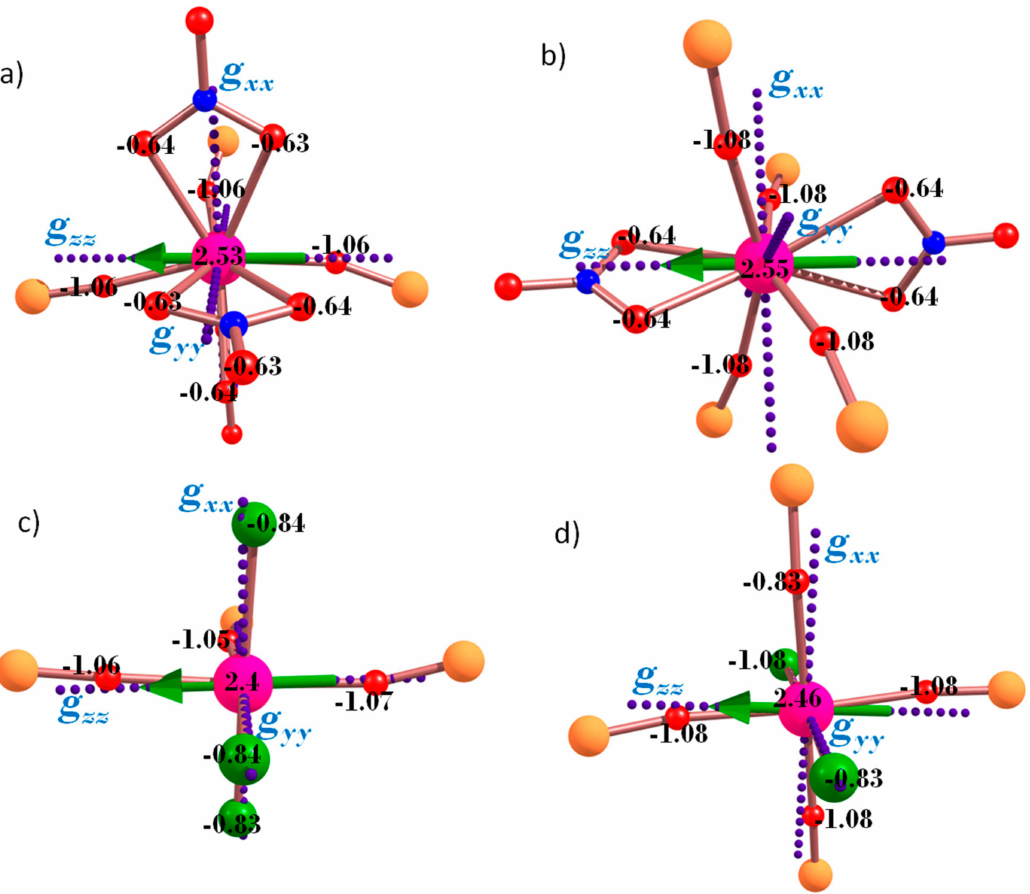
Figure 5. The orientation of the principle magnetization g zz , g xx , and g yy axis (dotted violet lines) and the main magnetic anisotropy direction (green arrows) of the Dy III ions along with the ab initio computed Loprop charge distribution on the coordinated atoms for ( a ) 1 ; ( b ) 2 ; ( c ) 3 and ( d ) 4 and 5 . Colour scheme: Dy III , pink; P, orange; Cl, green; O, red; N, blue. Calculations for 1 yield a ground to first excited state KD energy gap of 48.3 cm − 1 (Table